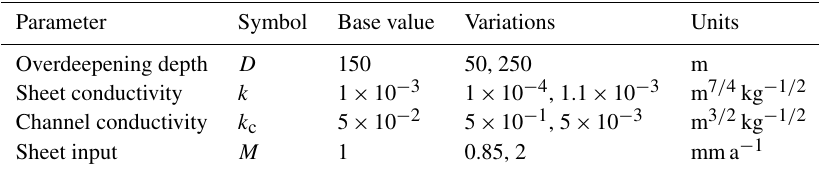
Table 2. Sensitivity test variables.